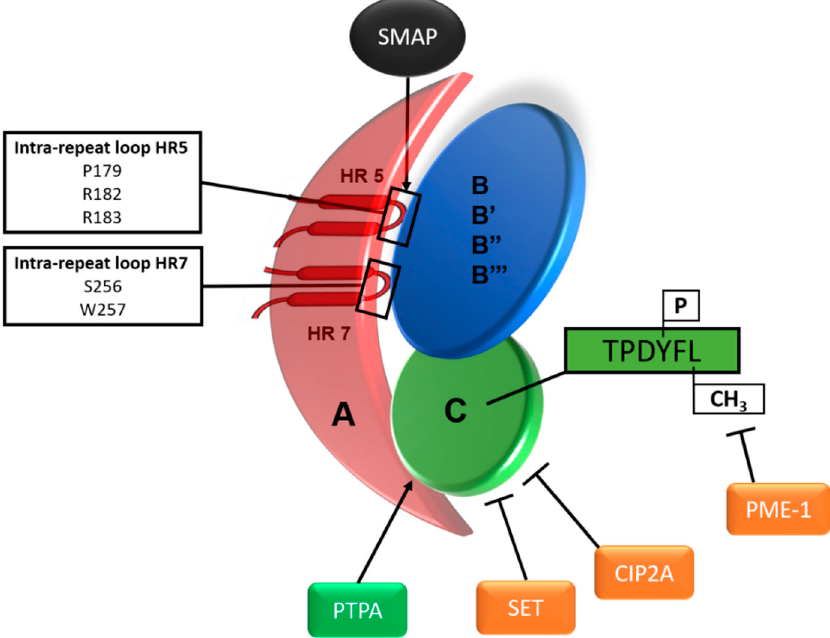
Figure 2. The heterotrimeric PP2A complex with activating and inactivating mechanisms. Heat repeat (HR) 5 and 7 are represented with their intra-repeat loops in subunit A. These intra-repeat loops harbour the most recurrent PPP2R1A hotspot mutations identified in type II ECs. Endogenous inhibition of PP2A can occur via SET, CIP2A and PME-1, which act on the C subunit. TPDYFL is the conserved motif in the C-terminal tail of the catalytic C subunit. Phosphorylation of the tyrosine (Y) is thought to cause inactivation, while methylation of the carboxyterminal leucine (L) of the C subunit promotes binding of specific B subunits, and thereby assembly of active trimers. PME-1 demethylates this leucine, and stabilises inactive PP2A complexes. PTPA is necessary for endogenous activation of inactive PP2A complexes. SMAP is a small molecule activator of PP2A, which binds at heat repeat 5 in close proximity to the hotspot mutations in PPP2R1A . The vast array of regulatory B subunits allows for the targeting of PP2A to many different substrates. A: Scaffolding A subunit; B, B ′ , B ″ , B ′′′ : The four families of regulatory B subunits, each containing several isoforms; C: catalytic C subunit; CH 3 : methyl group; CIP2A: cancerous inhibitor of PP2A; HR: heat repeat; P: phosphate group (PO 43 − ); PME-1: PP2A methylesterase 1; PTPA: phosphatase 2A phosphatase activator; SET: Suvar/Enhancer zeste/Trithorax; SMAP: small molecule activator of